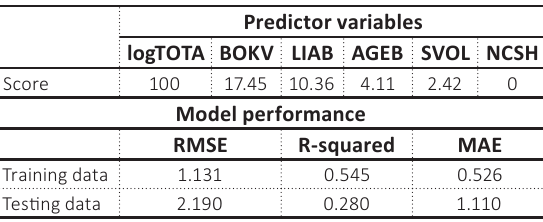
Table 6. Conditional inference tree variable importance scores and performance metrics for